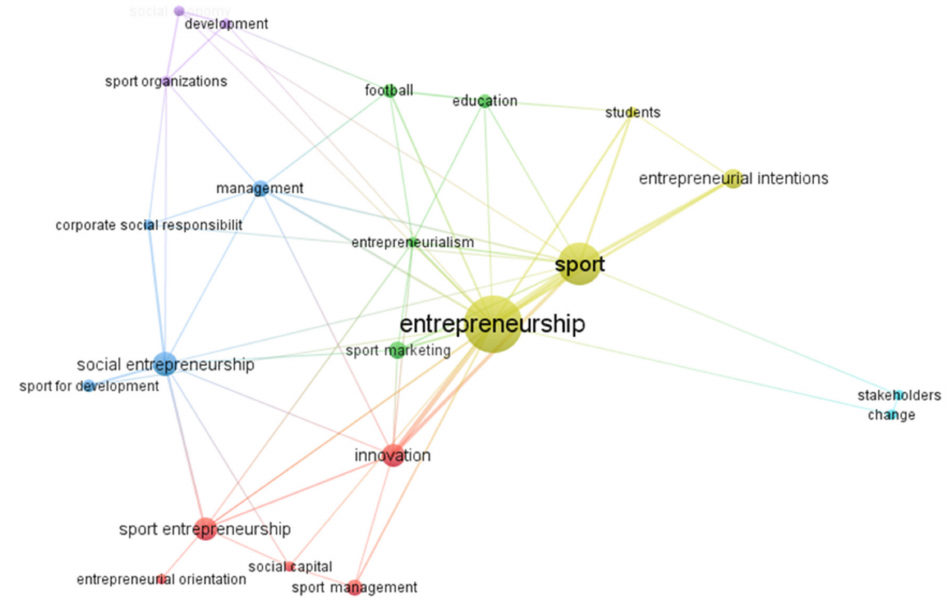
Figure 6. Co-keyword map of the sport entrepreneurship literature (threshold: 3